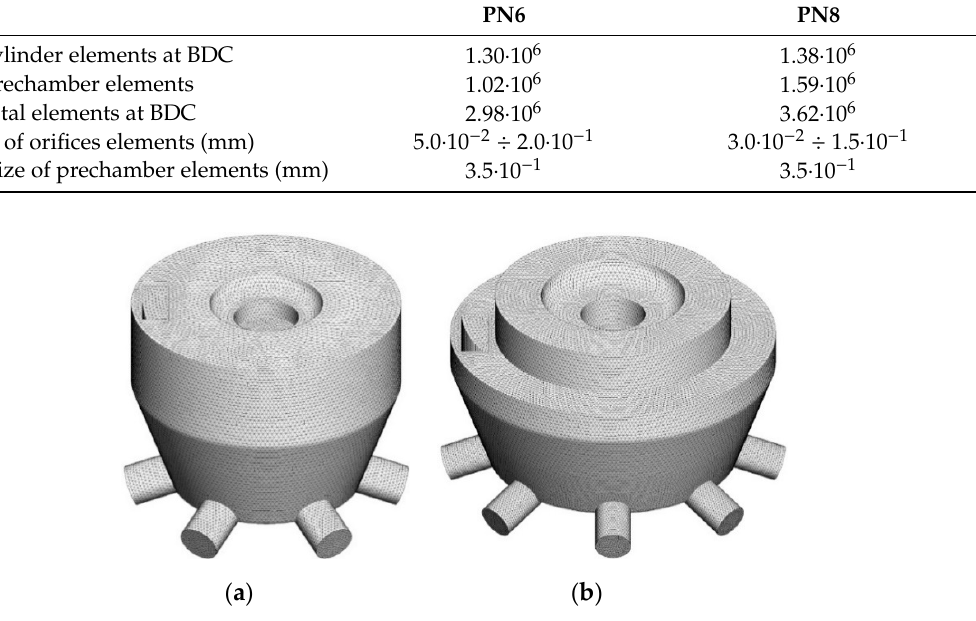
Figure 5. Side view of the mesh of the fluid domain inside the PN6 ( a ) and PN8 ( b ) prechambers.